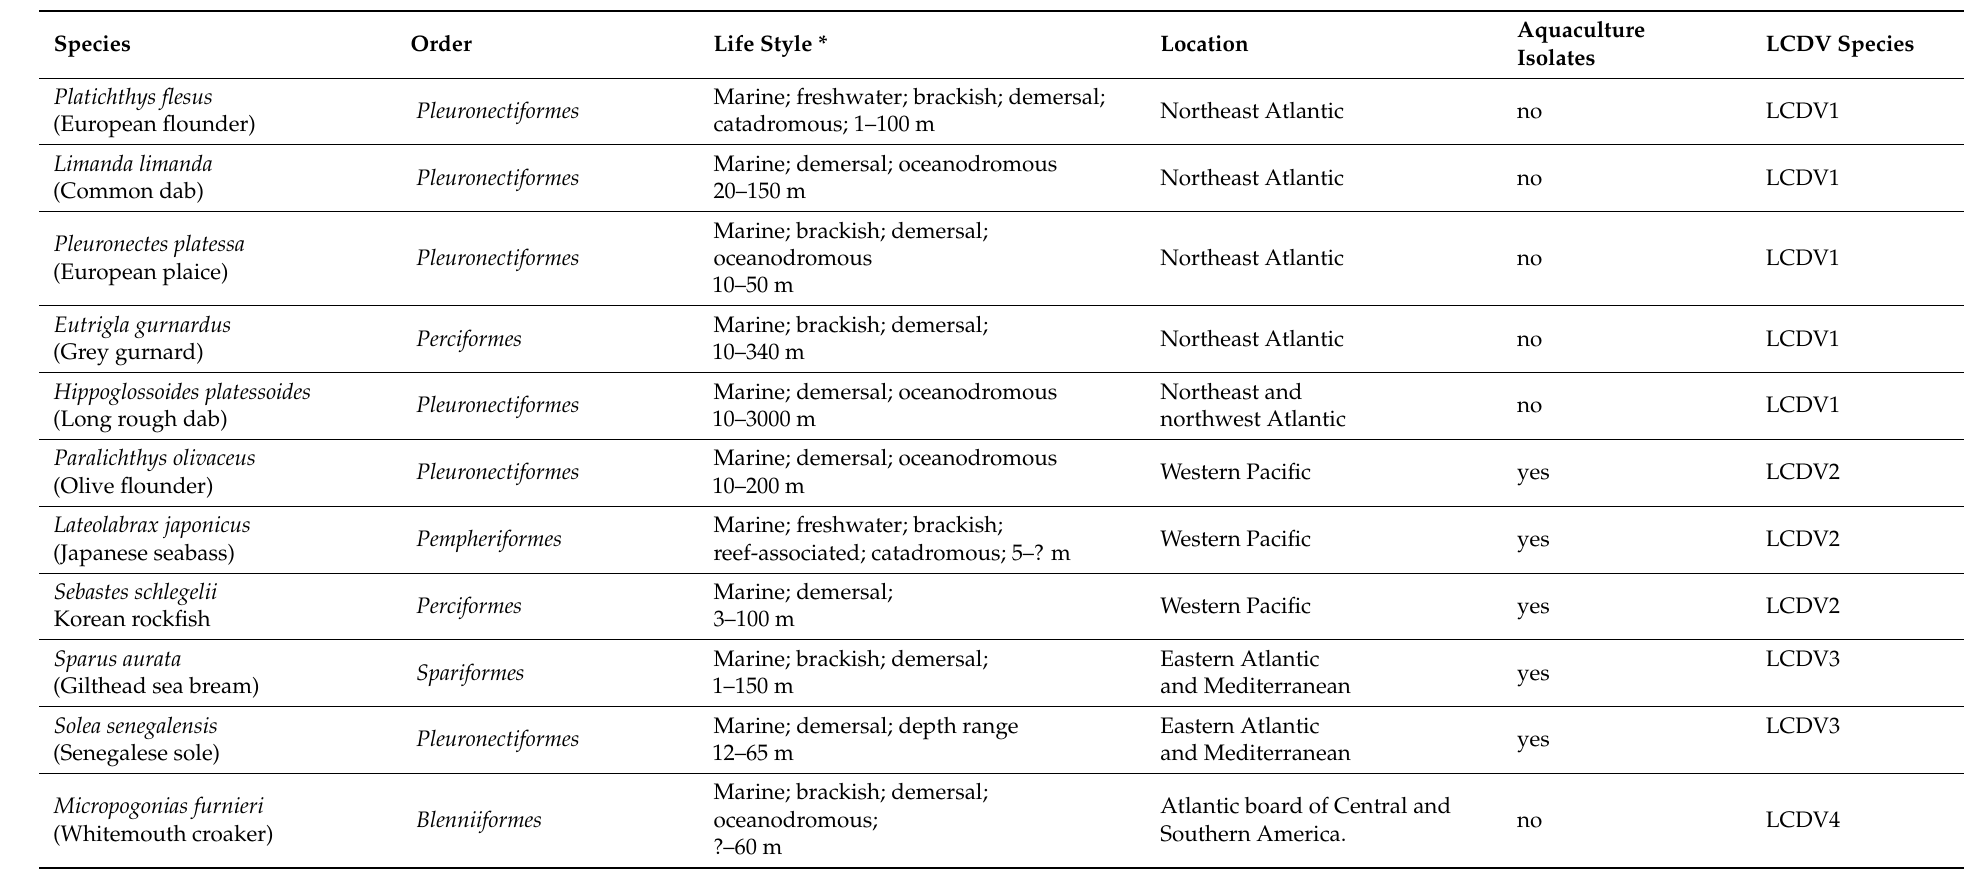
Table 4. LCDV genome types and their